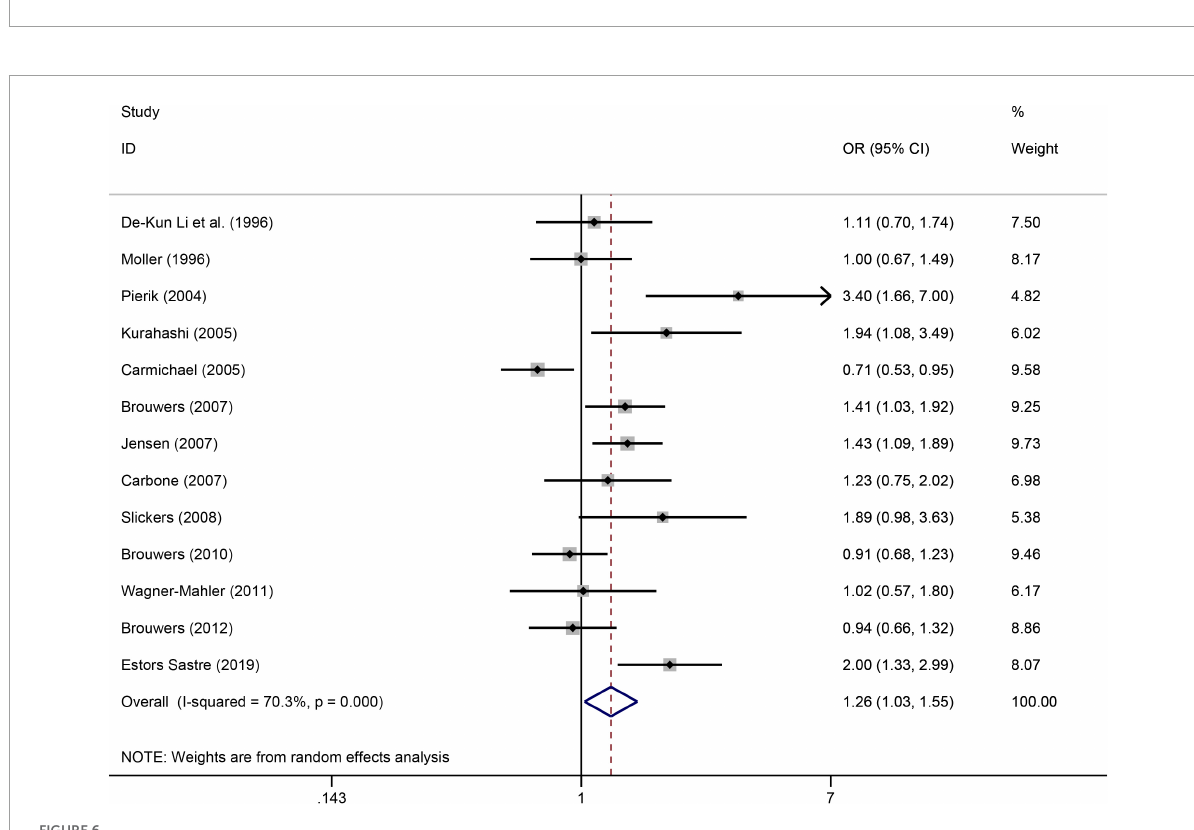
FIGURE5 Forest plot for the relationship between maternal smoking during pregnancy and the risk of kidney malformations. Studies were sorted by the sequence of publication time.